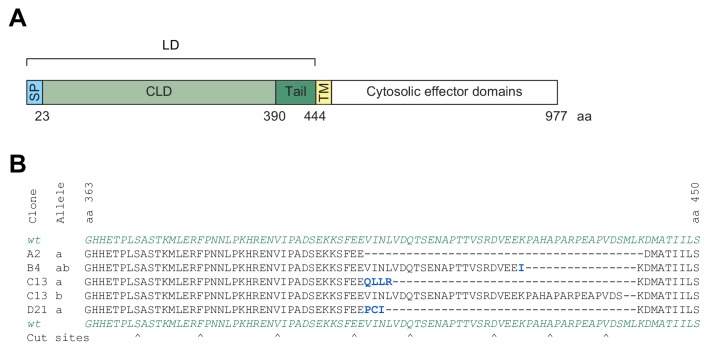
IRE1’s tail region is involved in maintaining the repressed state of IRE1 in vivo.(A) Schematic representation of IRE1. The signal peptide (SP), luminal domain (LD), comprised of a structured core (CLD) and an unstructured tail, the transmembrane (TM) domain and the cytosolic effector domains are indicated with their corresponding amino acid (aa) resides below. (B) Representative sequences of clones that were selected as described in Figure 3C after transfection of cells with guide-Cas9 encoding plasmids targeting IRE1’s tail (residues 368–444). Frameshift mutations are coloured in blue and Cas9 cut sites are indicated by arrowheads below.